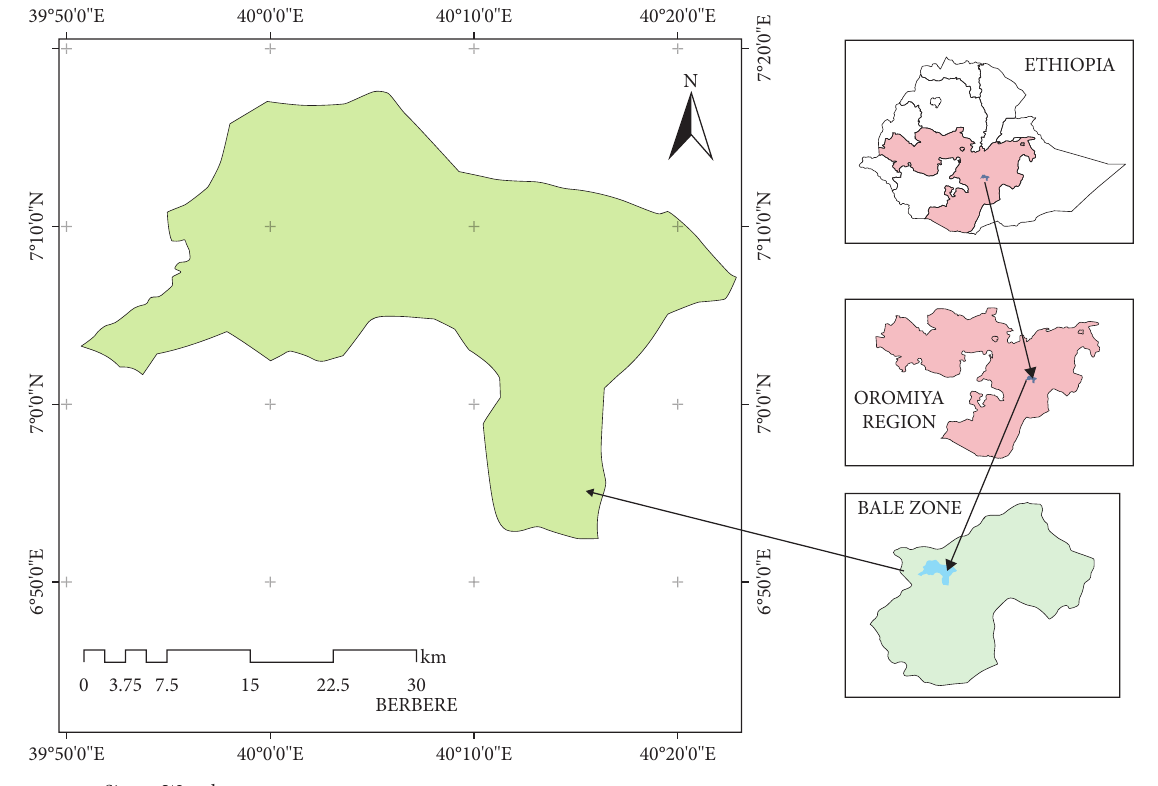
Figure 1: Map of the study area. Source: drawn by ArcGIS expert in 2020